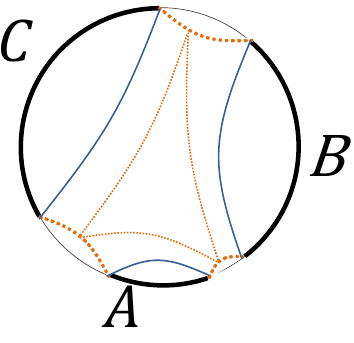
Figure 5 . The proof of a lower bound of (cid:1) W . The sum of dashed yellow lines is (cid:1) ABC + S ABC and the sum of real blue lines are S A + S B + S C . Clearly (cid:1) W ( (cid:26) ABC ) + S ABC (cid:21) S A + S B + S C follows since the entanglement entropy are de(cid:12)ned as minimal surfaces.